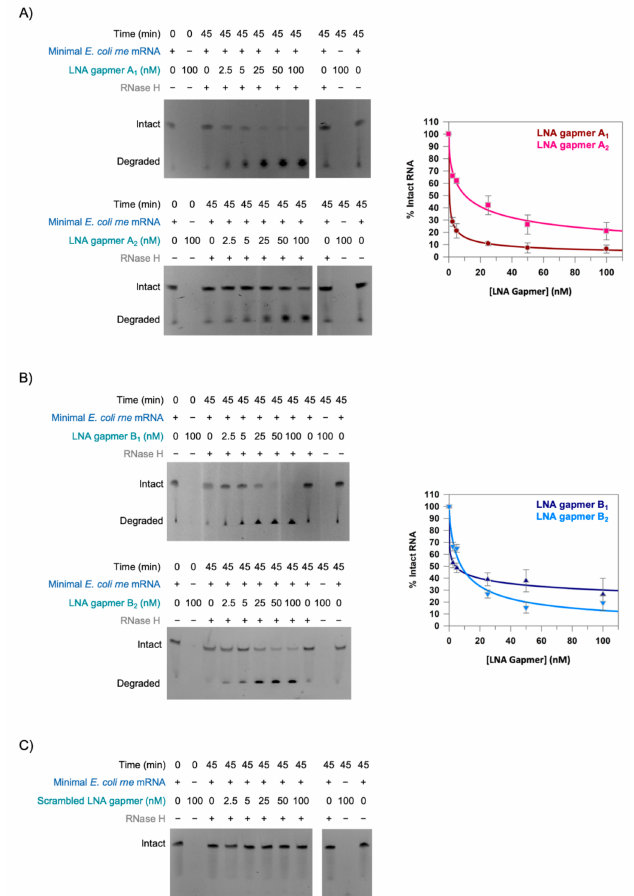
Figure 4. LNA gapmers stimulate RNase H-mediated cleavage of the translation initiation region of E. coli rne mRNA. Representative denaturing urea-PAGE analysis of RNase H cleavage assays performed in the presence of increasing concentrations of LNA gapmer as described in Materials and Methods. ( A ) LNA gapmers A 1 and A 2 . ( B ) LNA gapmers B 1 and B 2 . ( C ) Scrambled LNA gapmer. The contrast in the images has been adjusted to aid visualisation. The minimal E. coli rne mRNA was present at 50 nM, where indicated (+). The LNA gapmers were present at the indicated concentration. RNase H was present at a concentration of 0.008 U/ µ L, where indicated (+). Note that the cleavage products migrate at or near the visible dye front. For this reason, we focused on the disappearance of the band representing the intact minimal E. coli rne mRNA. Plots of the percentage of intact minimal E. coli rne mRNA remaining at the end of the RNase H cleavage assay against LNA gapmer concentration are shown in ( A ) LNA gapmers A 1 and A 2 and ( B ) LNA gapmers B 1 and B 2 . Data are the mean from three experimental repeats and error bars represent the SEM. Data were fit (solid line) to a four-parameter logistic function as described in Materials and